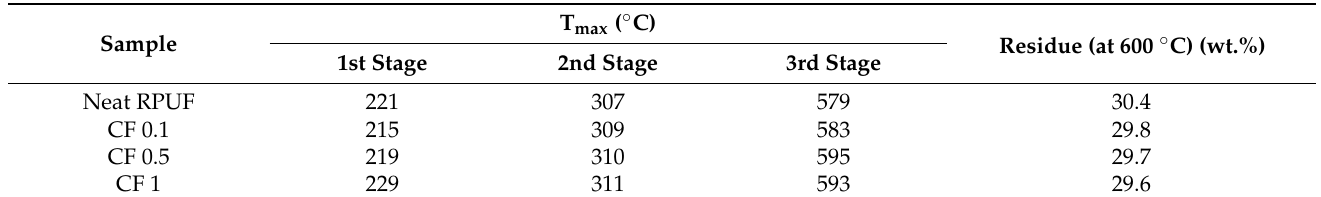
Table 5. Main results from thermogravimetric analysis (TGA) of the studied RPUF composites.